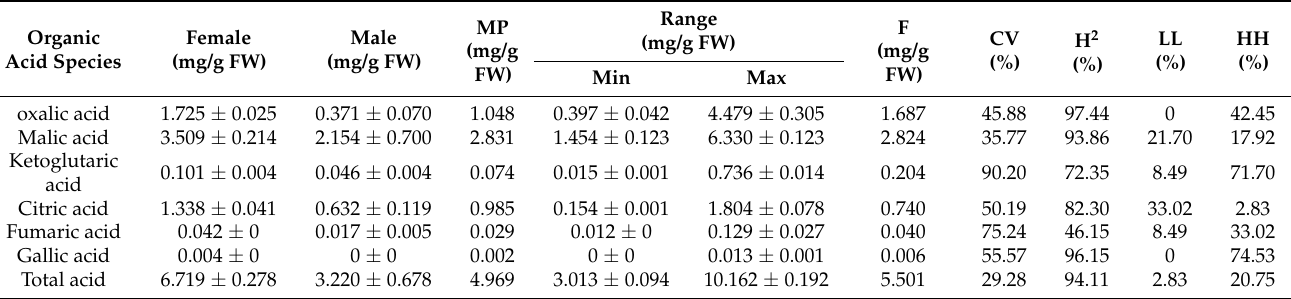
Table 2. Estimates of variability and genetic parameters for organic acid content in 101 hybrids and their